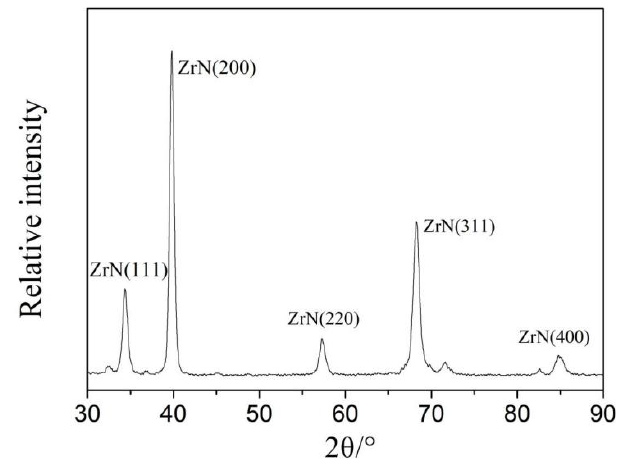
Figure 7. XRD pattern of ZrN coatings.